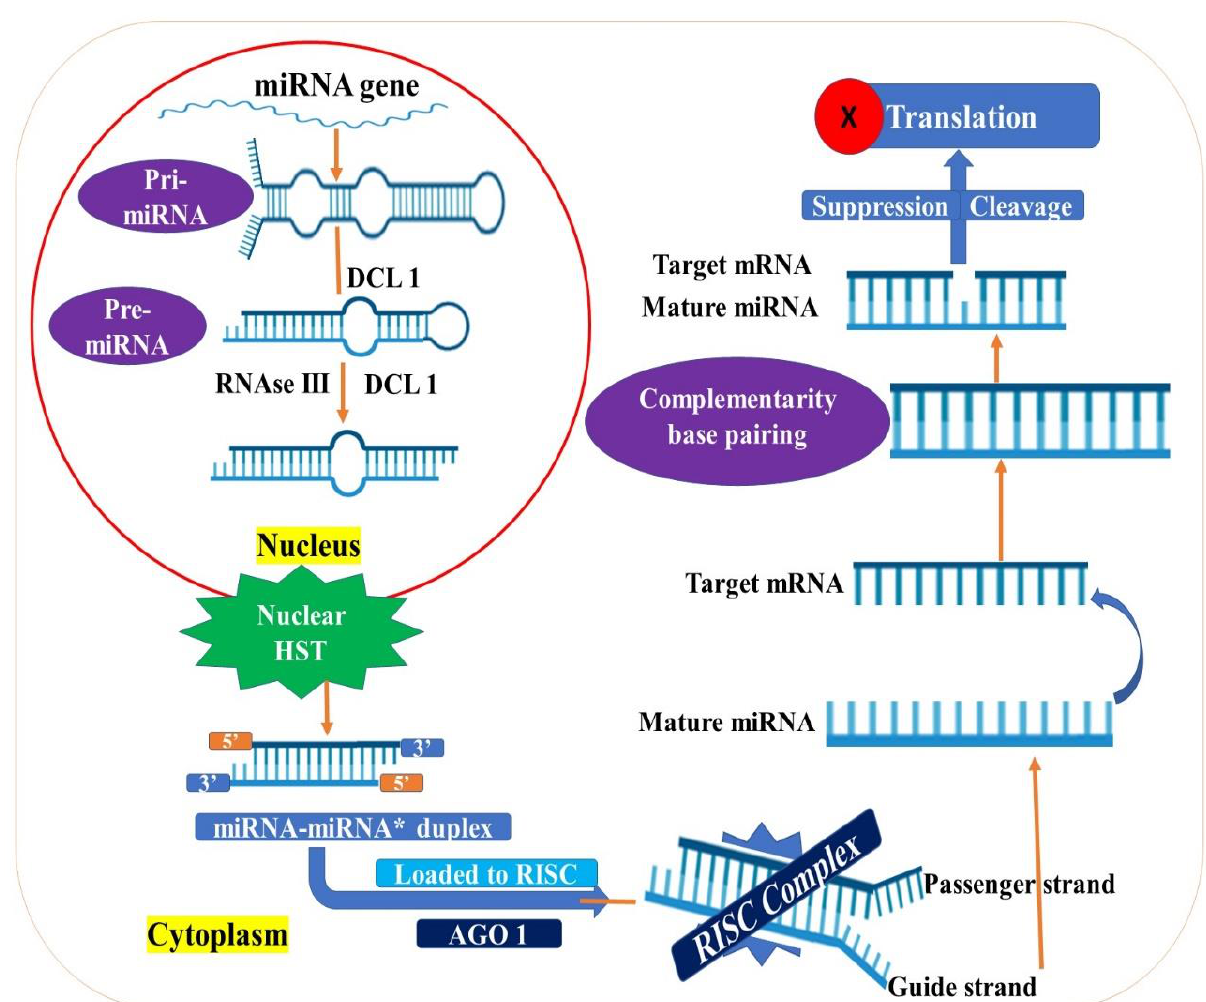
Figure 2. Generalized scheme to illustrate the various steps involved in plant miRNA biogenesis and activity. The miRNA genes are transcribed to primary miRNA transcripts (pri-miRNAs) of 100–120 nt long by RNA polymerase II that are then capped and polyadenylated. In the first maturation step of miRNA synthesis, pri-miRNA is cleaved by DCL 1 in collaborative action of other enzymes to form precursor miRNA (pre-miRNA) of approximately 70–100 nt long. In the second maturation step, the hairpin structured pre-miRNA is processed by the same enzymes to mature miRNA duplex. The DCL 1 cleavage results in the formation of a miRNA – miRNA* duplex of 21 to 24 nt containing two nucleotide 3′ overhangs and 5′ monophosphate regions. This duplex is transported out of the nucleus and into the cytoplasm, where it associates with an AGO (Argonaute) containing protein complex to form RNA induced silencing complex (RISC). The RISC is guided to the target sequence of single-stranded mRNA. Depending upon the nature of miRNA and AGO, the target mRNA is either cleaved or subjected to suppression of translation .